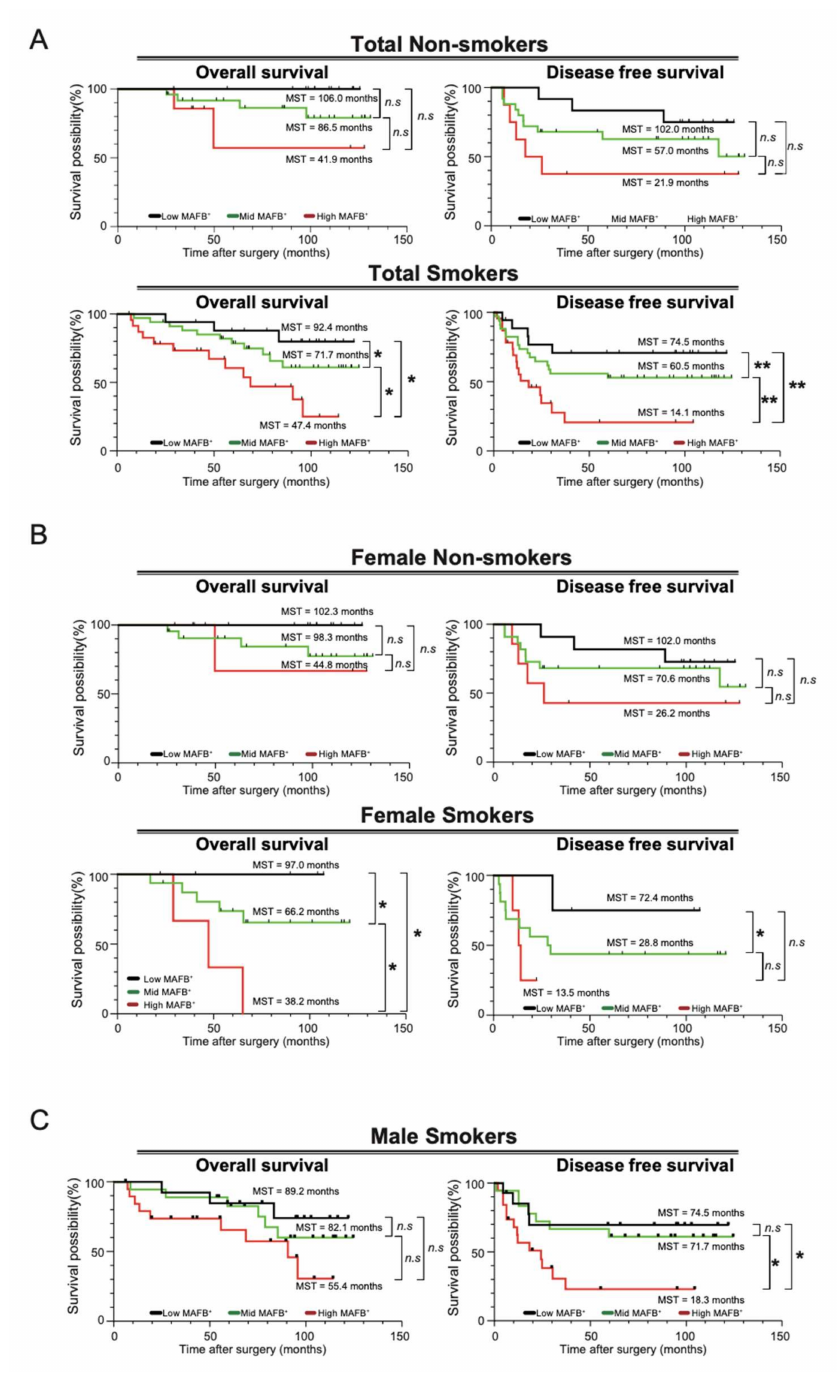
Figure 4. OS and DFS analysis in smokers and non-smoker patients. Kaplan–Meier analysis of ( A ) the overall survival and disease-free survival of the low-MAFB + , mid-MAFB + , and high-MAFB + in the total smoking and non-smoking patients; ( B ) the overall survival and disease-free survival of the low-MAFB + , mid-MAFB + , and high-MAFB + in female smoker and non-smoker groups; and ( C ) the overall survival and disease-free survival of the low-MAFB + , mid-MAFB + , and high-MAFB + in male smoker and non-smoker groups. Difference in survival was compared using log-rank test. *, p < 0.05; **, p <